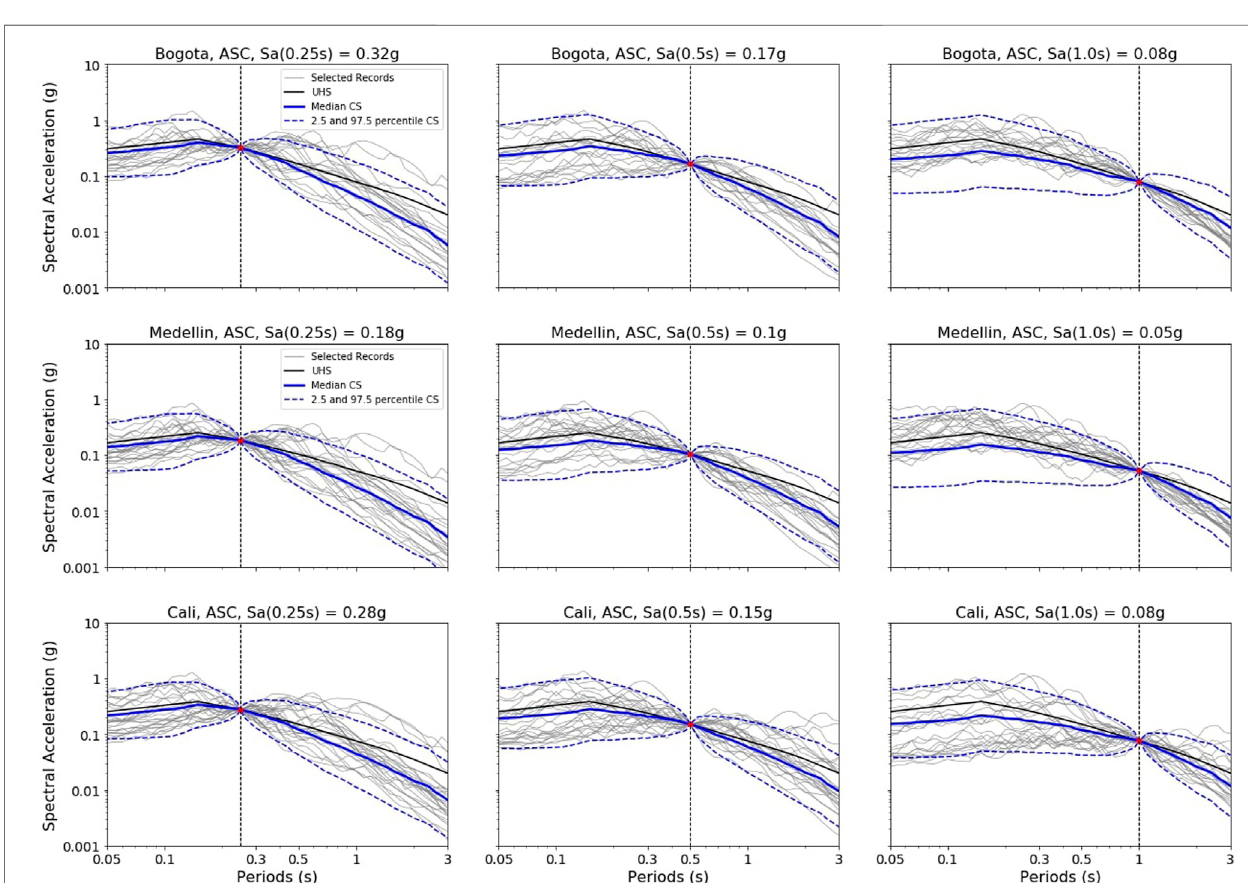
FIGURE 5 | Conditioned spectra (CS), response spectra from the records selected, and uniform hazard spectra (UHS) for active shallow crust at the intensity measurelevelof10%probabilityofexceedancein50 yearsforSa(0.25s)left,Sa(0.5s)center,andSa(1.0s)rightforthethreecities:Bogotá(top),Medellín(center),and Cali (bottom). Continuous blue thick line: median CS. Dash-lines: 2.5 and 97.5 CS percentiles. Continuous grey thin lines: records selected.